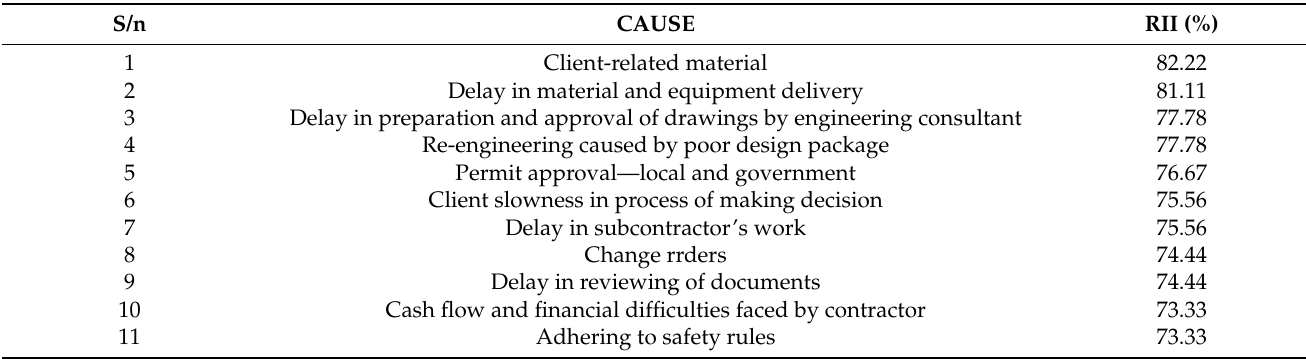
Table 7. Top ten causes from contractor point of view.